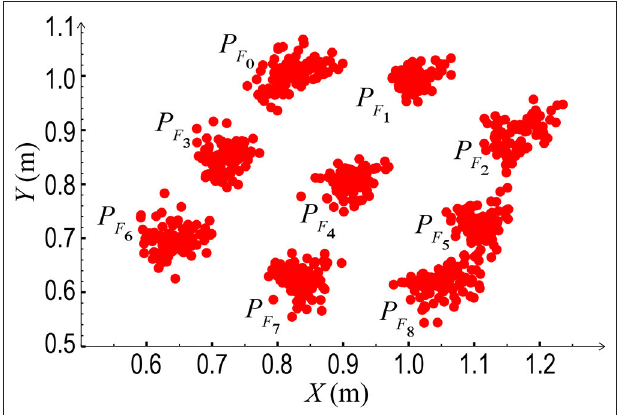
FIGURE 15 | Estimated positions of nine P F each P F ). i